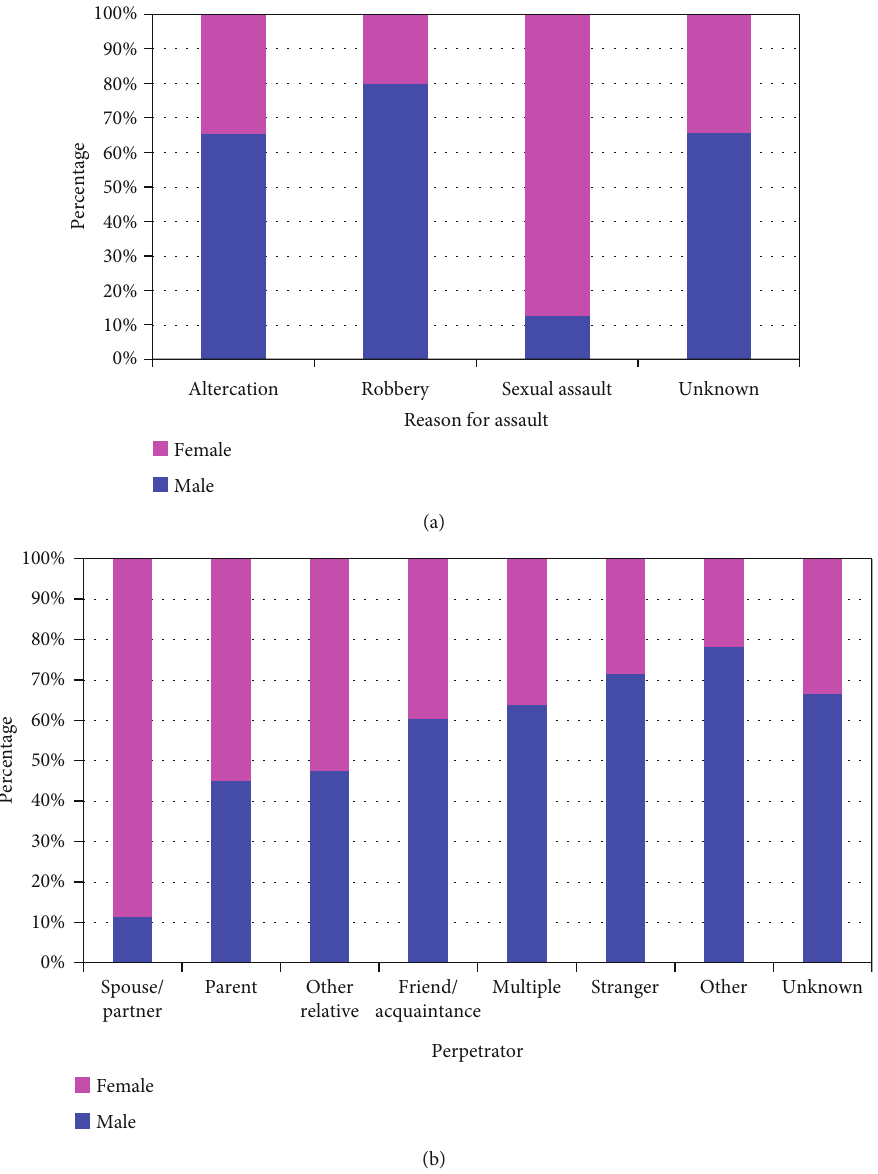
Figure 1: Di ff erences by gender in child and adolescent assault victims. (a) By reason for assault ( p < 10 − 4 ). (b) By perpetrator of assault ( p < 10 − 4